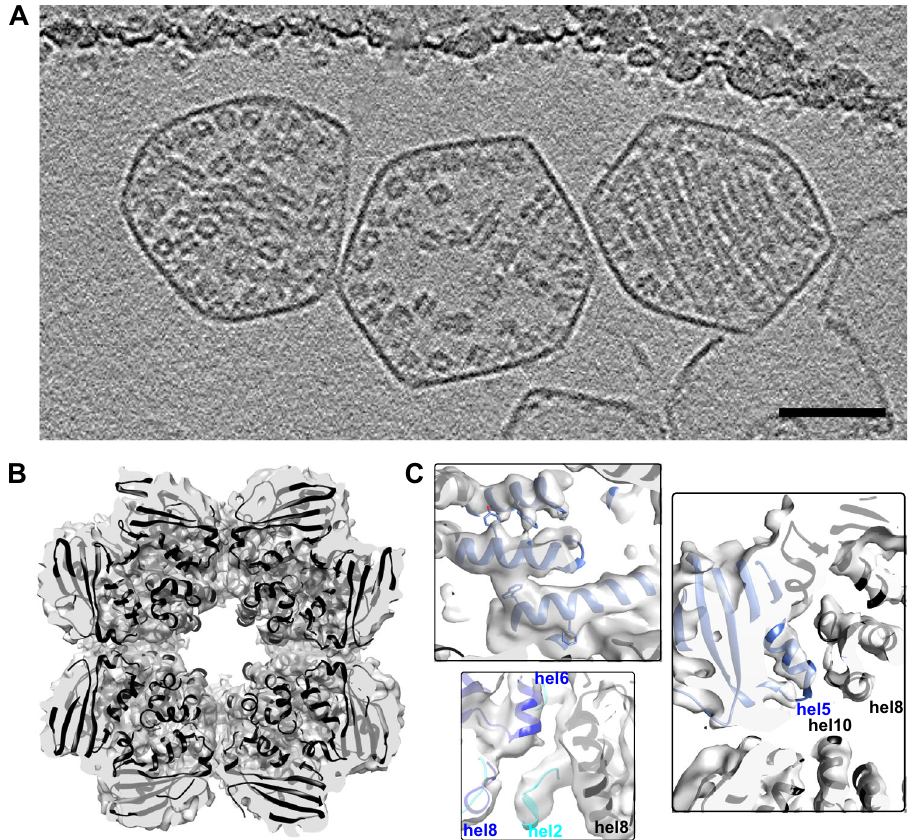
Fig.2|Rubiscosubtomogramaveraging.A 4.4nm-thickorthosliceshowingthree carboxysomes with different packing behaviors. From left: dense, sparse, ordered. Scale bar 50nm. B Slab view of the 4.5Å density map, with the 1SVD crystal structure docked inside (ribbon). C 1SVD crystal structure docked within the